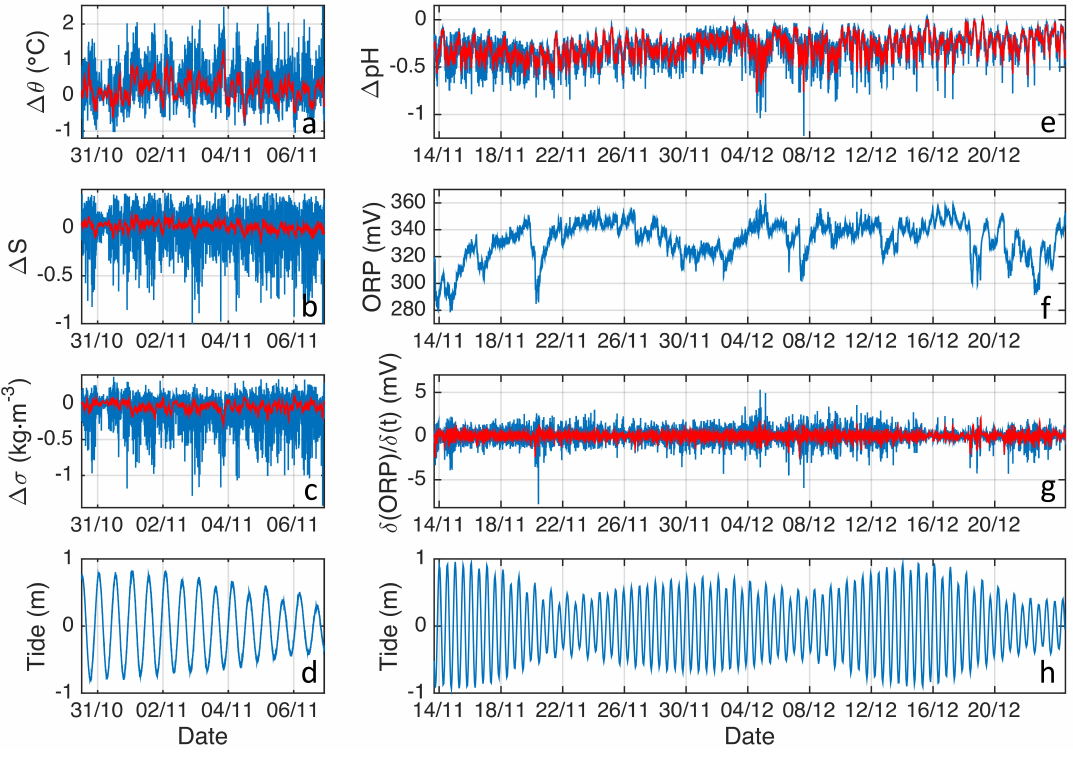
Figure 4. Time series of ( a ) potential temperature anomaly, ( b ) salinity anomaly, ( c ) potential density anomaly, ( d ) pressure, ( e ) pH anomaly, ( f ) oxidation-reduction potential (ORP), and ( g ) ∂ (ORP)/ ∂ t recorded by an RBR CTD and Seabird 27 pH-ORP system mounted at a mooring deployed at the interior of the main crater at a depth of 127 m during October–December 2016. ( h ) Theoretical tide extracted by [54]. Red color shows the five-minute moving average time